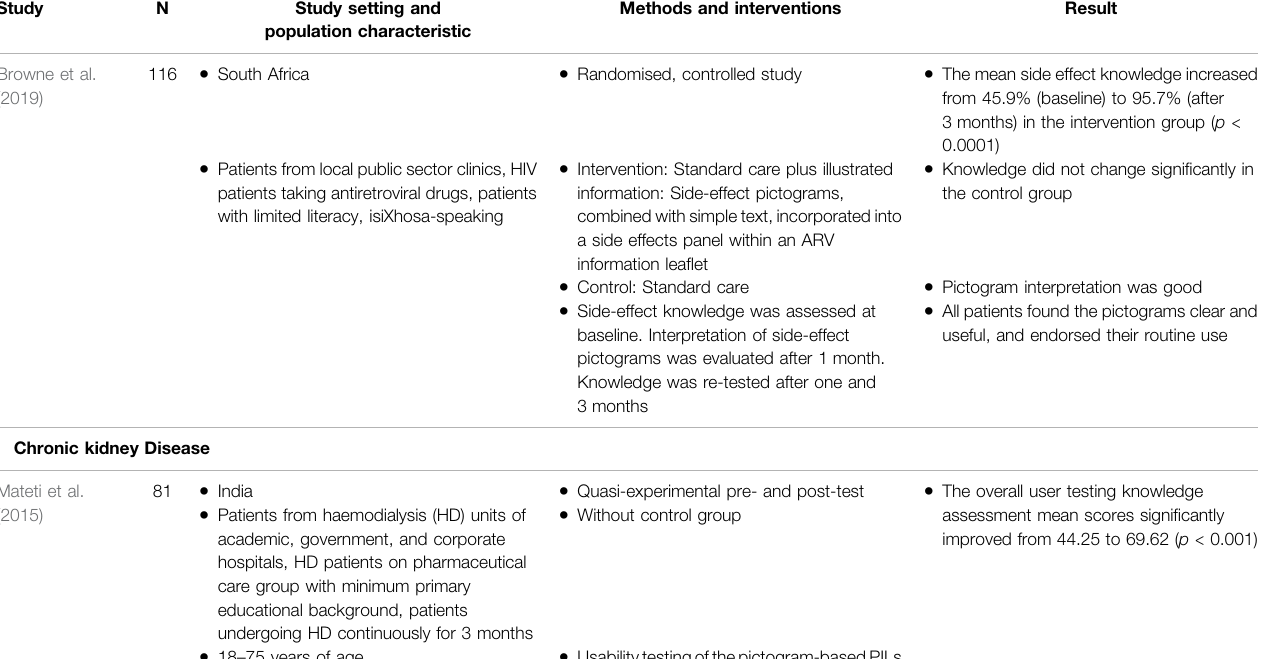
TABLE 1 | ( Continued ) Pictograms in the pharmaceutical care of chronically ill